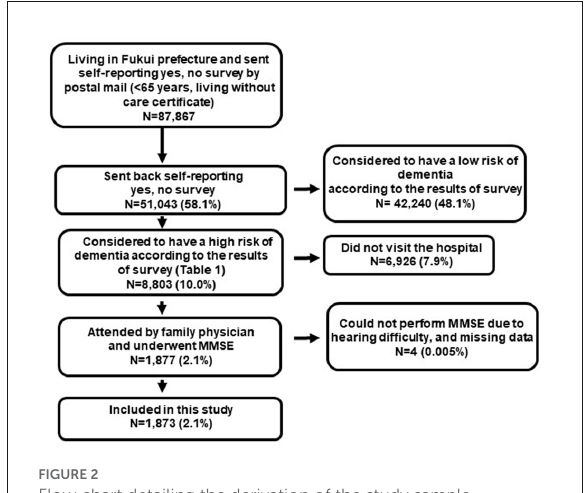
Statistics (version 27, IBM Corp, Armonk, NY, USA). Statistical significance was set at p < 0.05.